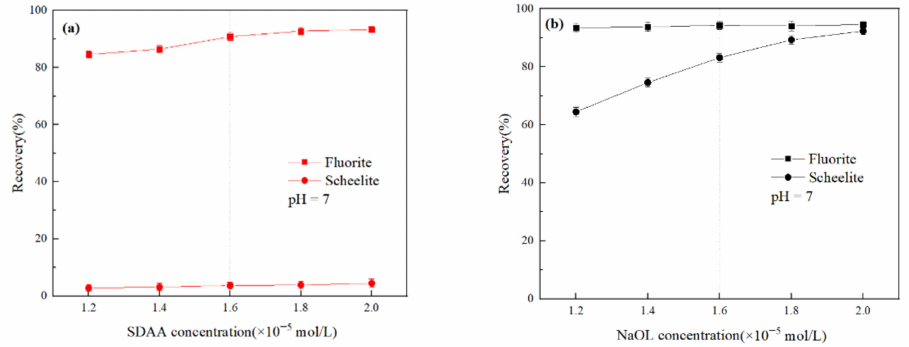
Figure 3. ( a ) Recoveries of fluorite and scheelite as a function of collector concentration using SDAA as the collector and ( b ) recoveries of fluorite and scheelite as a function of collector concentration using NaOL as the